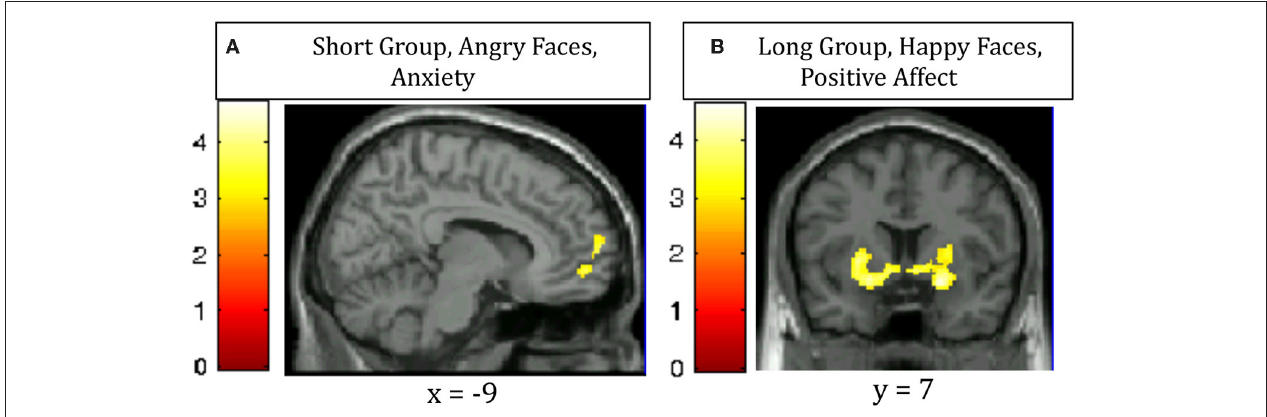
FIGURE 3 | Regions in which increased activation for the contrast of incongruent—congruent trials correlates with (A) increased anxiety in Short 5-HTTLPR individuals viewing Angry faces (ventromedial